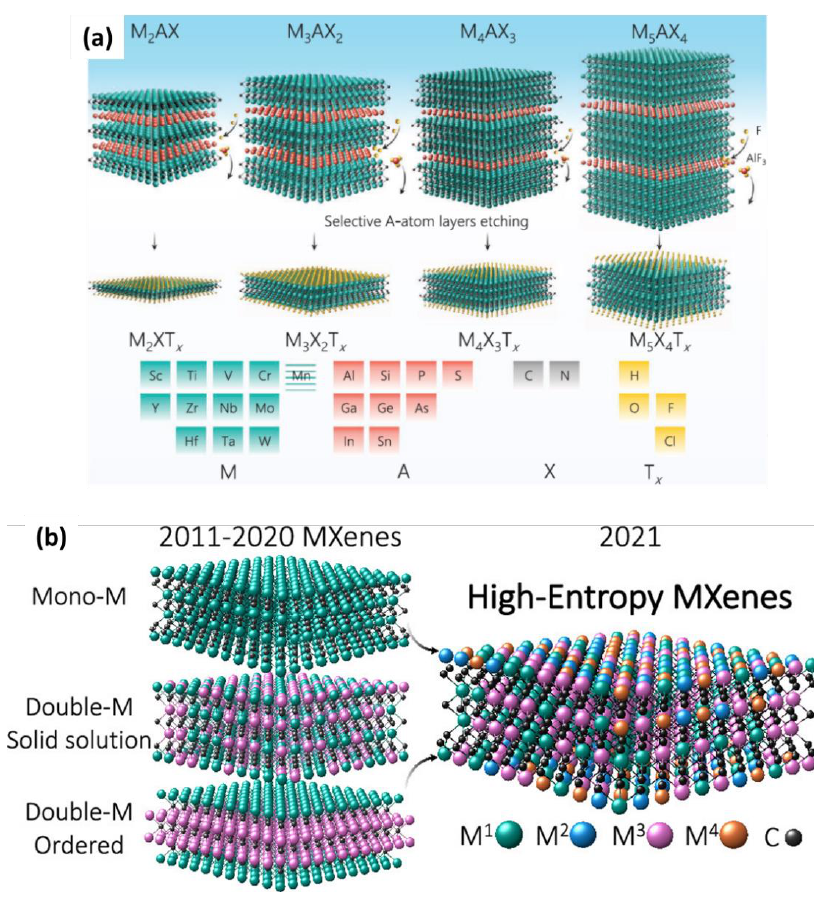
Figure 2. The HF-based synthesis of MXene from its MAX precursor and its effects as well as various forms of MXene. ( a ) A schematic representation of MAX structures from n = 1 to n = 4 and their etched MXene structures with transition metals, carbon/nitrogen, the majority of A-group elements, and surface terminations. Adapted with permission [10]. Copyright 2021, John Wiley and Sons. ( b ) High-entropy MXenes. Adapted with permission [11]. Copyright 2021, American Chemical